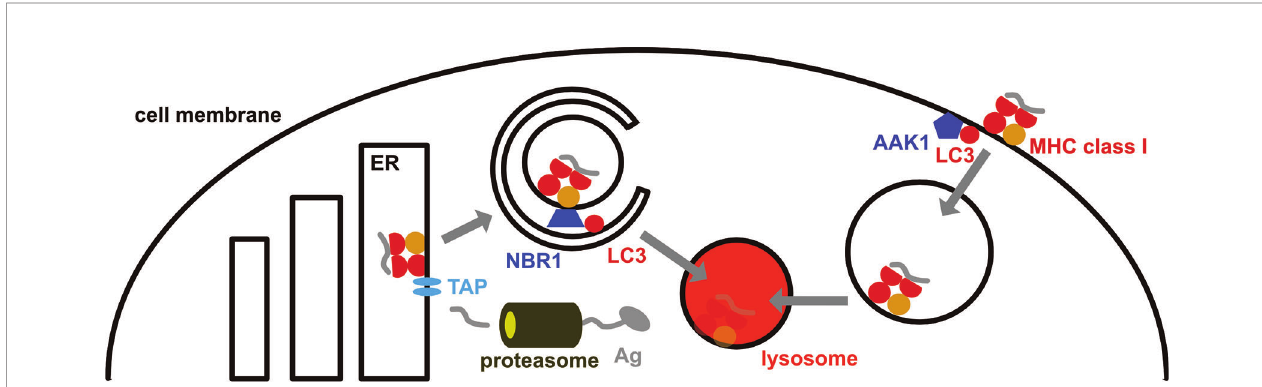
FIGURE 2 | MHC class I surface expression is down-regulated by the macroautophagy machinery. MHC class I molecules are loaded in the endoplasmic reticulum (ER), primarily with peptides that originate from proteasomal degradation and are then imported into the ER via the transporter associated with antigen presentation (TAP). On their way to the cell membrane from the ER, MHC class I molecules are targeted for macroautophagy by the autophagy receptor NBR1, resulting in their lysosomal degradation in pancreatic ductal adenocarcinoma (PDAC) cells. In addition, LC3 lipidation recruits parts of the internalization machinery to MHC class I molecules at the cell membrane, including AP2 associated kinase 1 (AAK1). This leads to a more rapid internalization and degradation of MHC class I molecules in dendritic